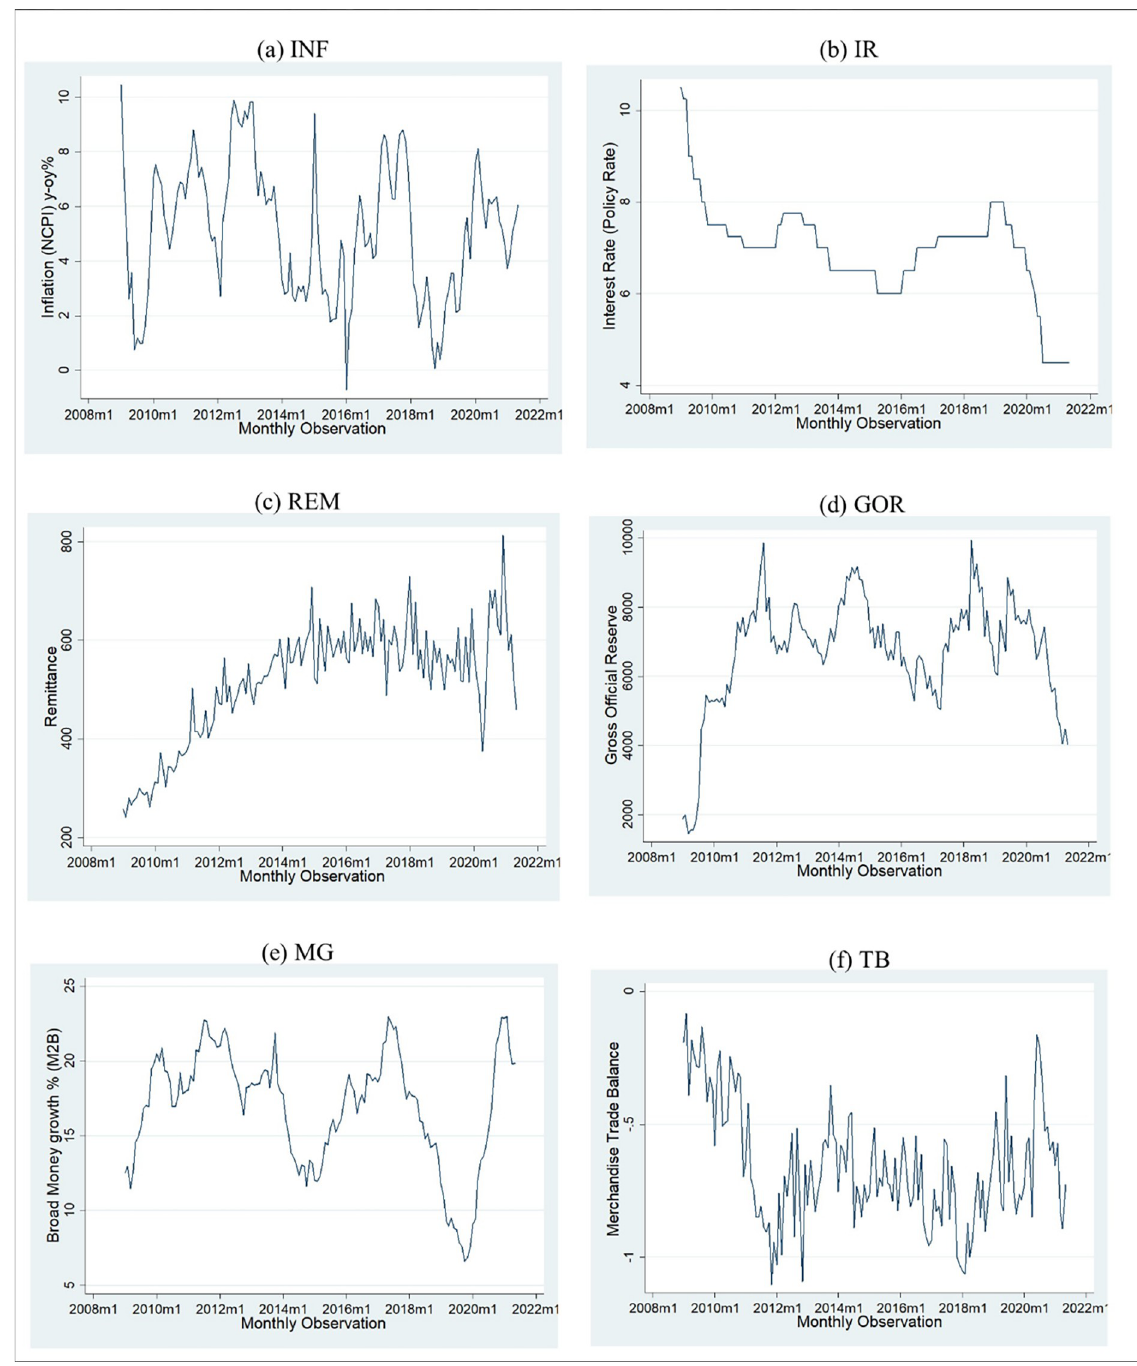
Fig 4. Stationarity time series of the examining variables. Source: Authors’ construct based on the collected data.